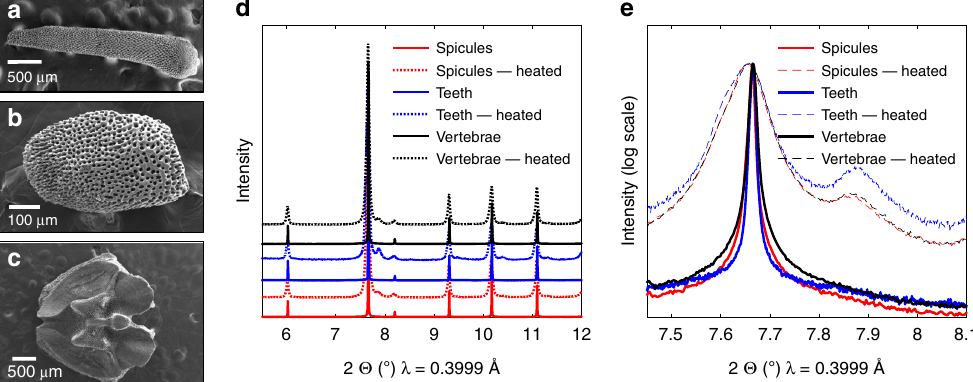
Fig. 4 Other calcitic parts ’ morphology and structure. a – c HRSEM images of the O. wendtii brittle star, showing a arm vertebrae, b spicules, and c teeth of the organism. d Diffractogram of these calcitic parts at room temperature and after heating treatment at 400 °C. e Zoom-in on the (104) diffraction peaks plotted on logarithmic scale